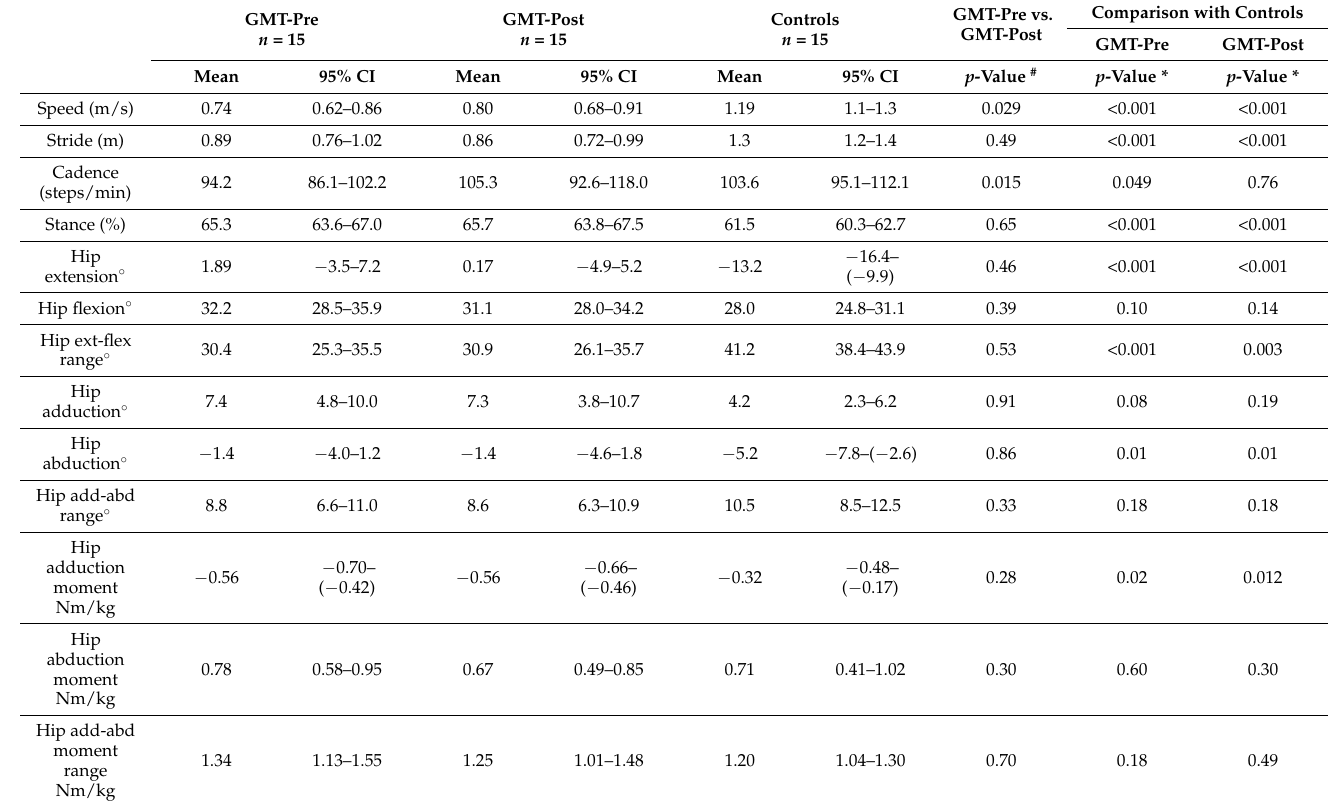
Table 2. Gait parameters in 15 controls and 15 patients undergoing gluteus maximus transfer pre- and postoperatively at the two-year follow-up.